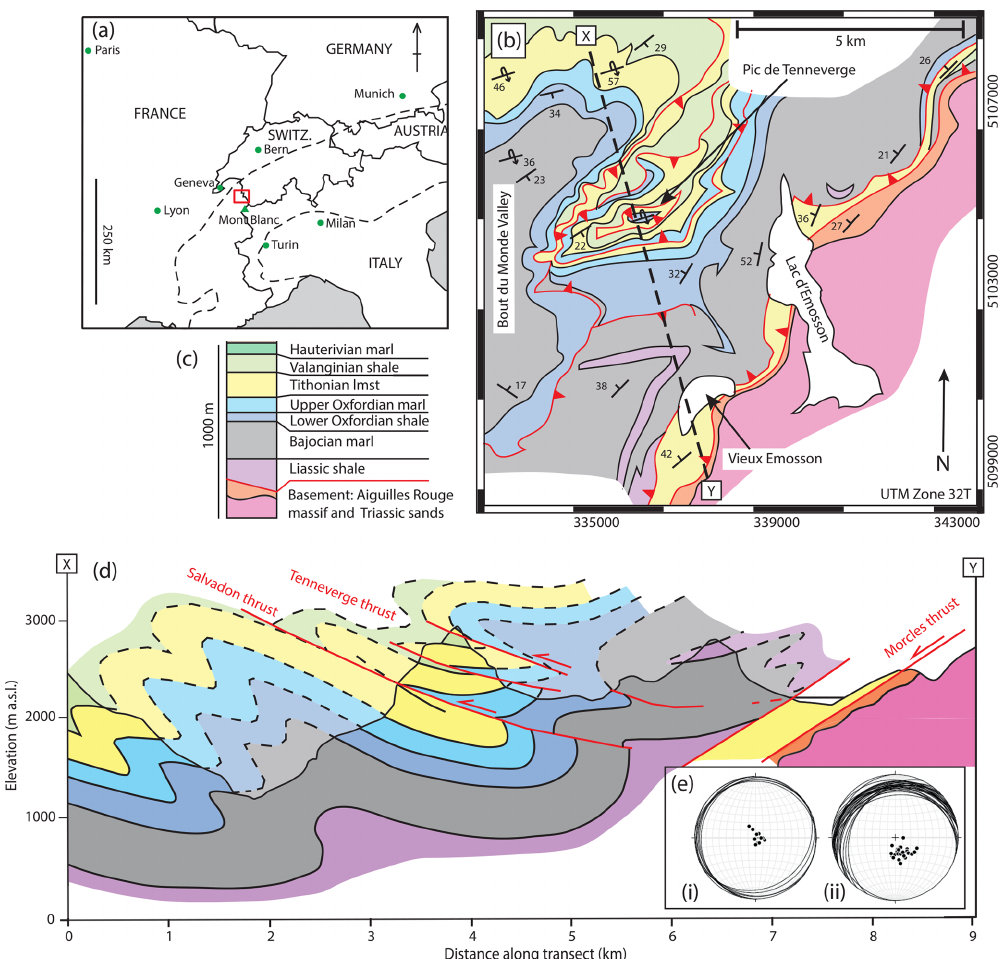
Figure 1. Geology of the Haut Giffre. (a) Location of the Haut Giffre region (red box) within the Alpine chain (dashed lines) on the French–Swiss border. (b) Simplified geological map of the eastern Haut Giffre, including major thrust faults and regional dips. Significant geographic features are labelled. The cross-section line x – y is indicated by a dashed line. (c) Main lithological units outcropping in the Haut Giffre. (d) NNW–SSE cross-section as indicated by line x – y in (a) . (e) Stereonets showing cleavage and poles to cleavage at the (i) highest stratigraphic levels (lower Oxfordian and above, limited to Pic de Tenneverge massif) and (ii) lowest stratigraphic levels (within 1km of the Morcles